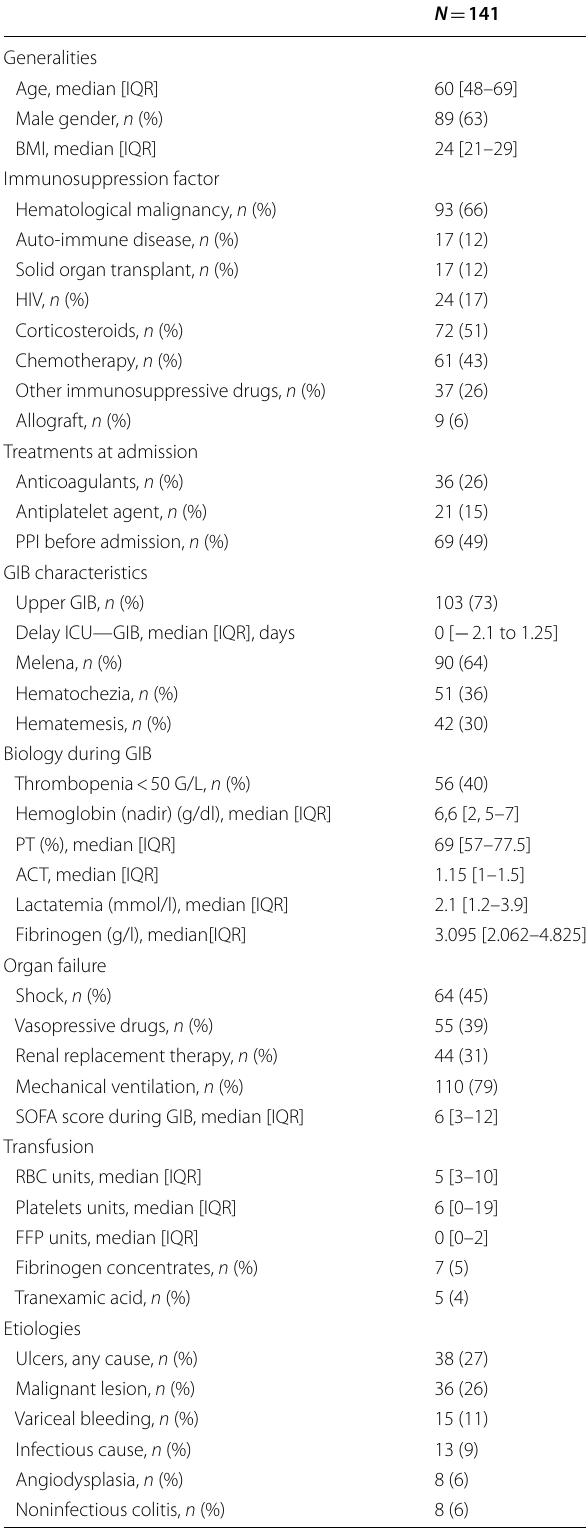
Table 1 Immunocompromised patients’ characteristics